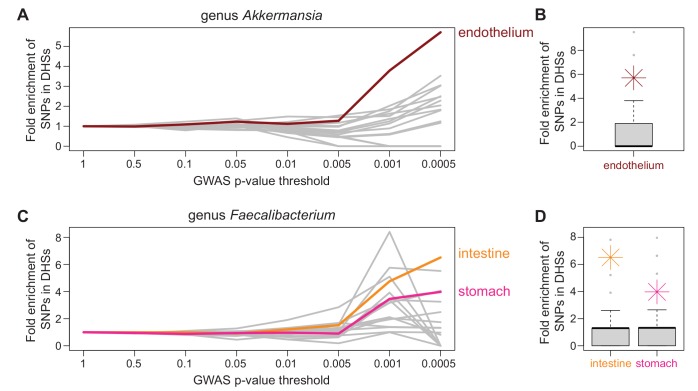
Identification of candidate tissues.At increasingly significant P-value thresholds, variants identified through GWAS were enriched in DNase hypersensitivity peaks in a tissue-specific manner. A) For genus Akkermansia, low P-value GWAS SNPs were significantly enriched in DHS peaks in endothelial cell types (red), but not in DHS peaks of the 15 other tissues examined (gray). The x-axis shows the P-value threshold bins examined and y-axis represents fold enrichment for SNPs overlapping DHS peaks in that bin compared to genome-wide for that tissue type. Both the abundance of genus Akkermansia and endothelial barrier function have been associated with obesity, providing a mechanistic hypothesis that can be further investigated. B) For genus Akkermansia, the significance of enrichment of GWAS SNPs overlapping DHS peaks in endothelial tissue in the lowest P-value bin (P ≤ 0.0005) was determined by GWAS permutation (P ≤ 0.05, see Materials and Methods). The distribution of permuted GWAS SNP enrichments in DHS peaks of endothelial tissue is displayed as a boxplot with actual enrichment plotted as red star. C) For genus Faecalibacterium, low P-value GWAS SNPs are significantly enriched in DHS peaks of both intestine (orange) and stomach (pink) tissues (P ≤ 0.05). D) For genus Faecalibacterium, the significance of enrichment of GWAS SNPS overlapping DHS peaks of both intestine and stomach tissues in the lowest P-value bin (P ≤ 0.0005) was determined by GWAS permutation (intestine P ≤ 0.01, stomach P ≤ 0.05, see Materials and Methods). Members of Faecalibacterium are some of the most common species in the gut and are known to be associated with dysbiosis in patients with irritable bowel syndrome. The distribution of permuted enrichments for each identified candidate tissue is displayed as a boxplot with actual enrichment plotted as an orange (intestine) and pink (stomach) star.